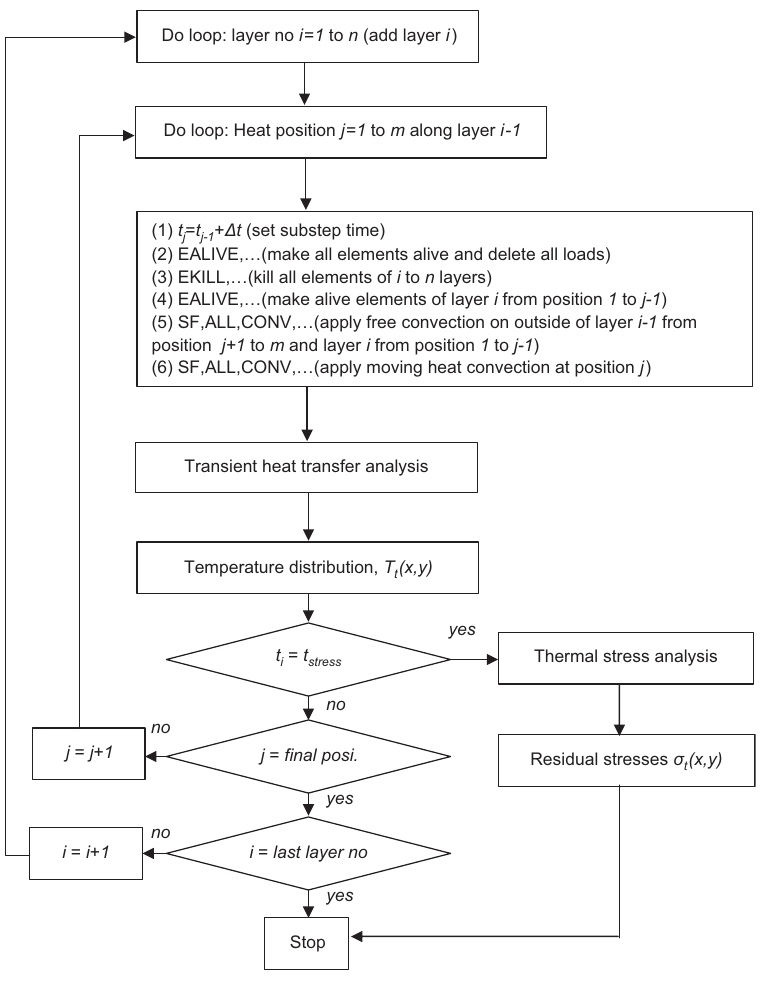
Figure 5 Flow chart for the solution